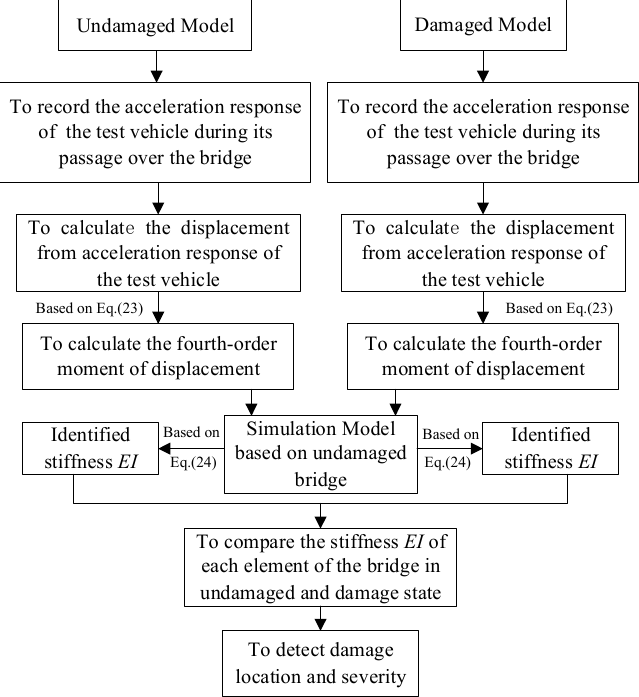
Figure 3. Flowchart of the time-domain method.